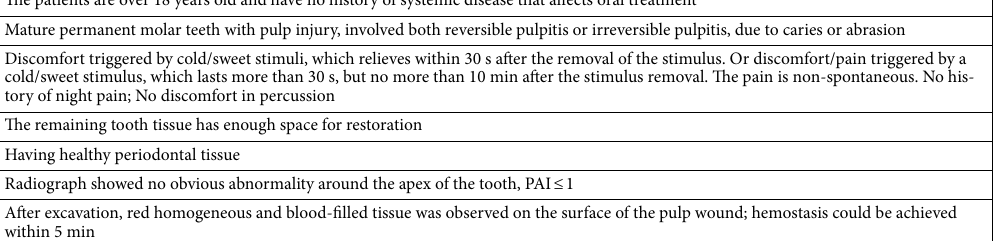
Table 1. Inclusion criteria.